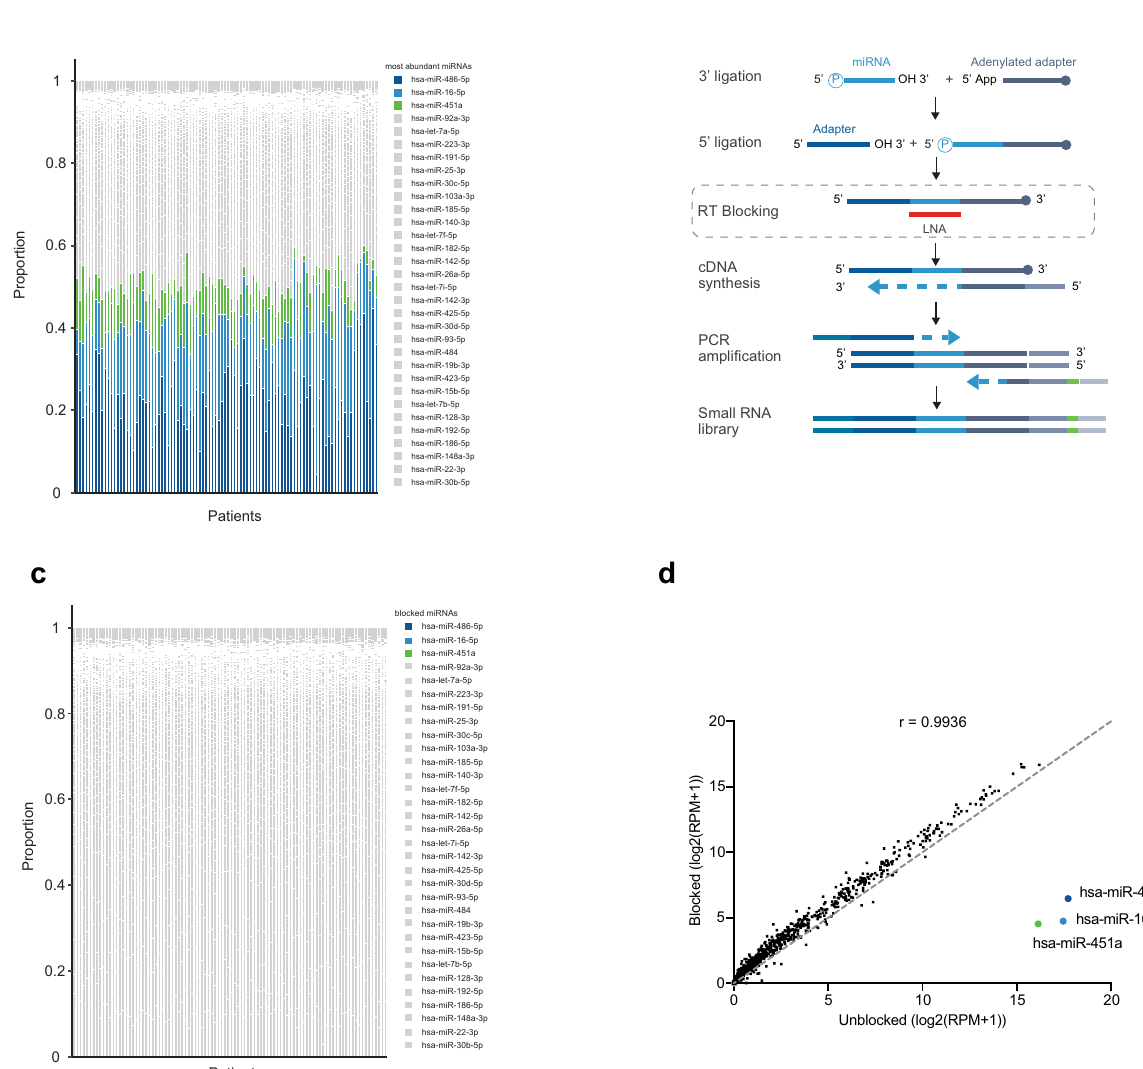
Fig. 1 Whole blood small RNA sequencing pipeline with blocking of highly abundant miRNAs. a Sequencing of whole blood from 96 NSCLC patients revealed that ~50% of reads per patient map to hsa-miR-486-5p, hsa-miR-16-5p, and hsa-miR-451a. b The standard miRNA library preparation protocol has been modi fi ed to block the incorporation of speci fi c miRNAs using antisense locked nucleic acid (LNA) oligonucleotides that block the reverse transcription of target miRNAs. c The three blocking target miRNAs have been almost entirely eliminated from the sequencing libraries therefore increasing the sequencing bandwidth available for the detection of other miRNAs. d Mean miRNA expression following sequencing of unblocked or blocked libraries reveals speci fi c depletion of the on-target miRNAs whilst maintaining a high correlation between the expression values of all other features ( r =